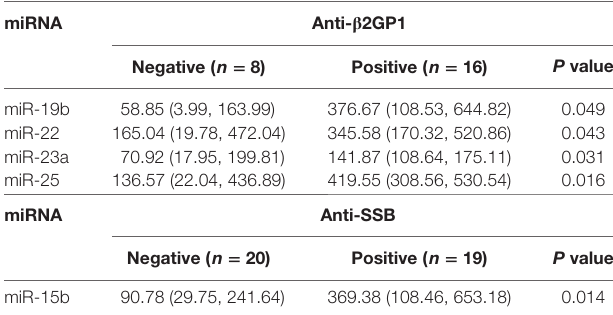
TaBle 6 | Correlation of 14 microRNAs (miRNAs) with anti-nuclear antibodies in systemic lupus erythematosus patients. mirna